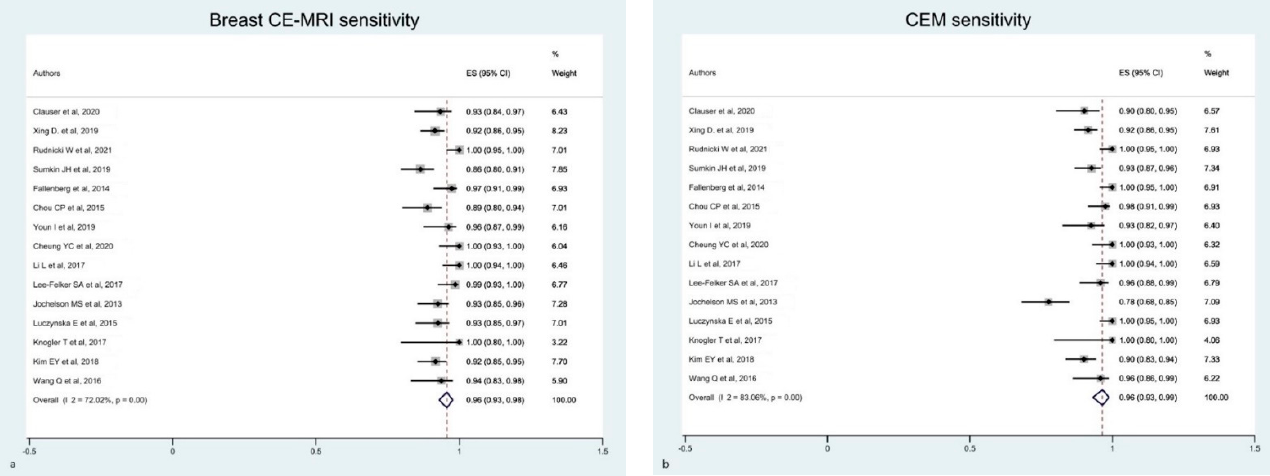
Figure 2. Forest plot of the estimated pooled sensitivity of breast CE-MRI ( a ) and CME ( b ) in the detection of pathological breast lesions, including index and secondary lesions. The estimated pooled sensitivity of CE-MRI ( a ) was 0.96 (95% CI 0.93–0.98), with a moderate heterogeneity (I 2 = 72.02% p = 0.001). The estimated pooled sensitivity of CME ( b ) was 0.96 (95% CI 0.93–0.99), with a high heterogeneity (I 2 = 83.06% p = 0.001) [16–19,21–26,28–30,33,34].